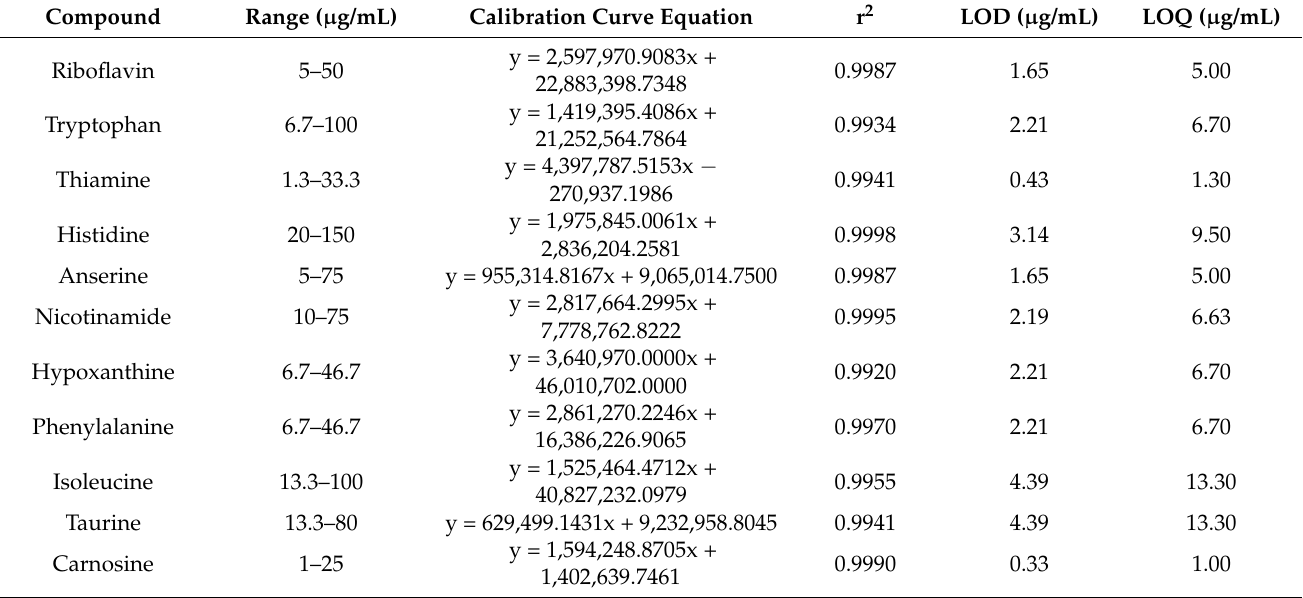
Table 2. Method validation